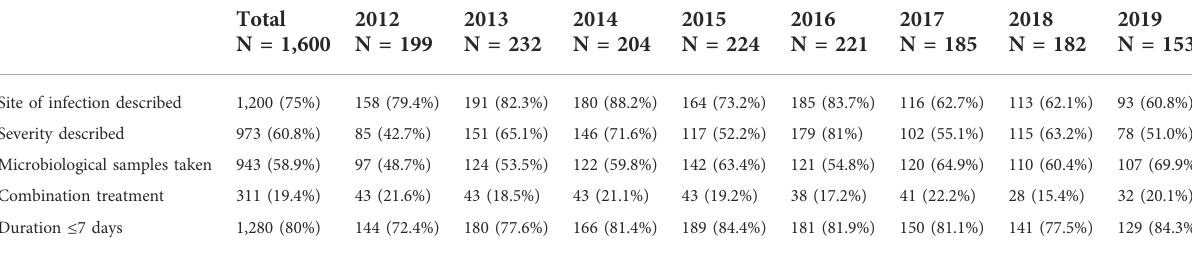
TABLE 3 Quality indicators rate per study year (2012 –